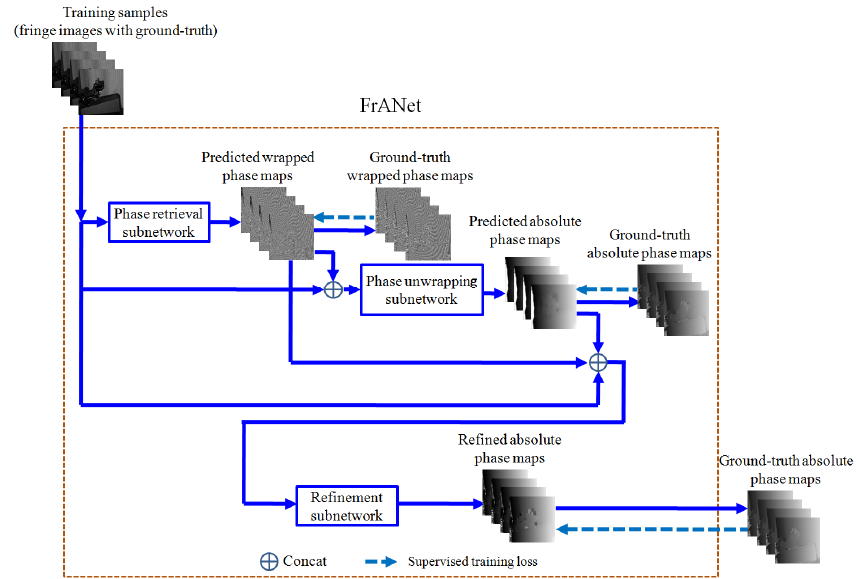
Figure 4. Overview of the supervised training process of the FrANet. The pseudocode for training the FrANet using a supervised data set is given in Algorithm 2.